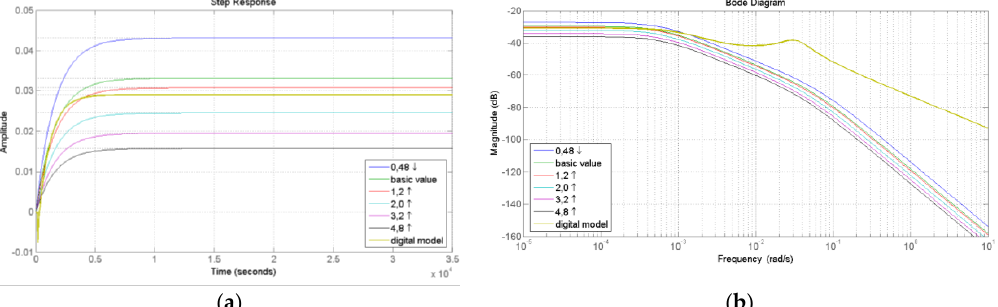
Figure 4. Segment G1 step ( a ) and frequency responses ( b ) for simulation of changes in diameter of flow channels.